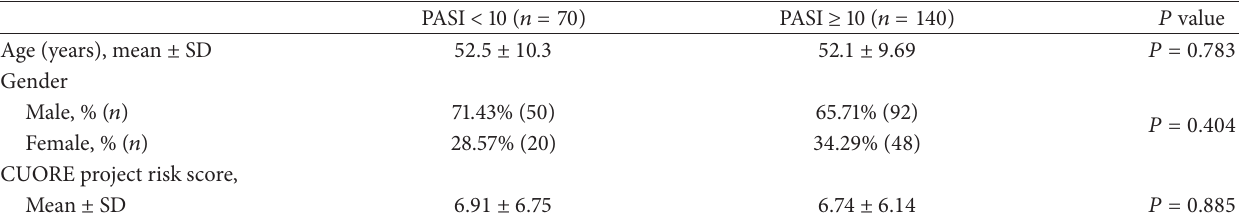
Table 4: Comparison of psoriasis severity and cardiovascular